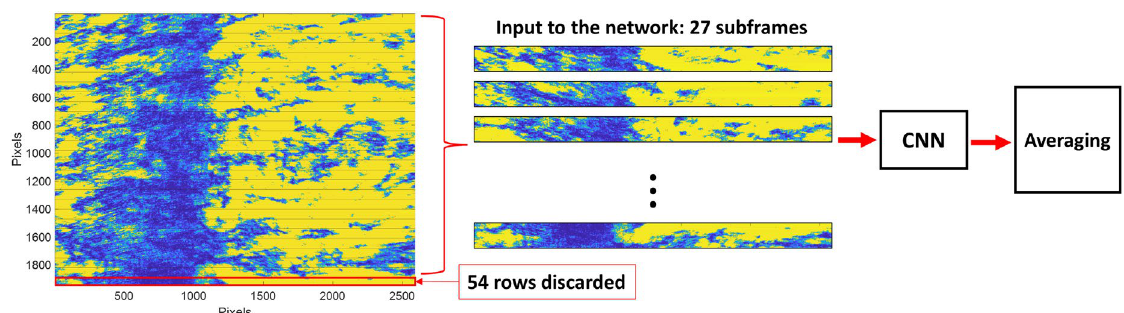
Figure 6. The DL testing process analyzing the experimental